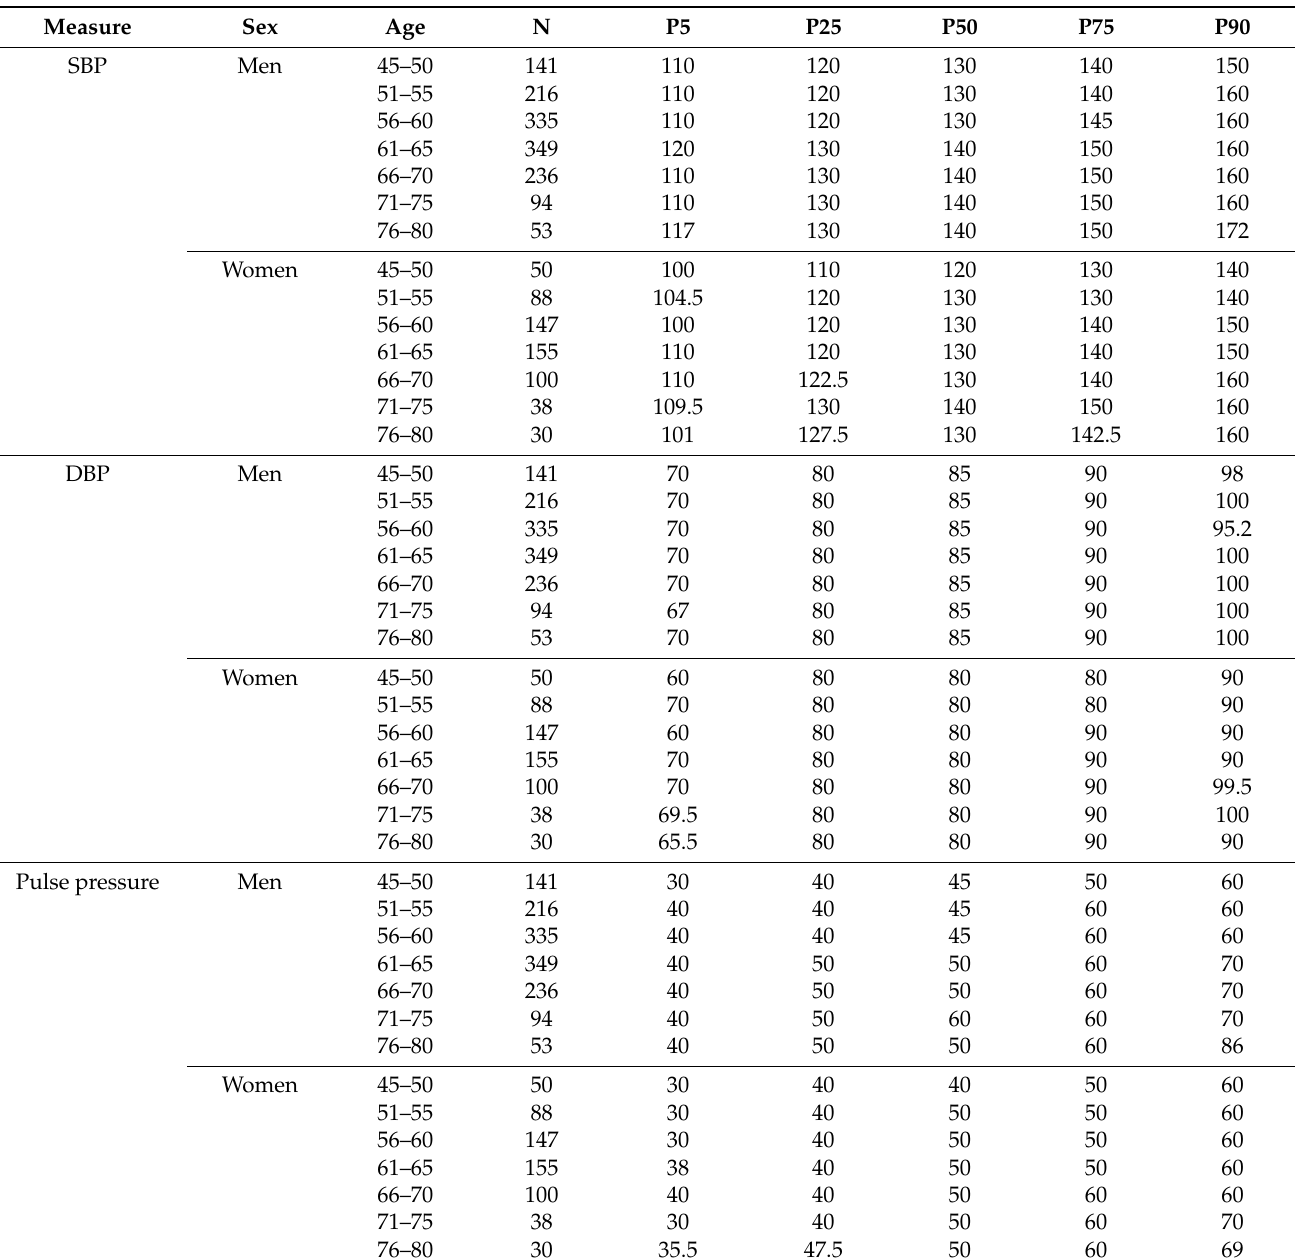
Table 2. Sex-specific and age-specific normative data for blood pressure in the study participants ( N = 2032). Measure Sex SBP